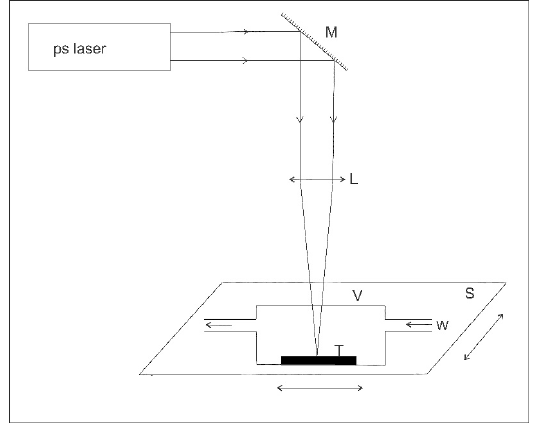
Figure 1. Experimental setup for stationary laser irradiation of targets in water. M—mirror; L—focusing lens; T—target; V—vessel; W—water circulated through vessel; S—x-y translation stage.